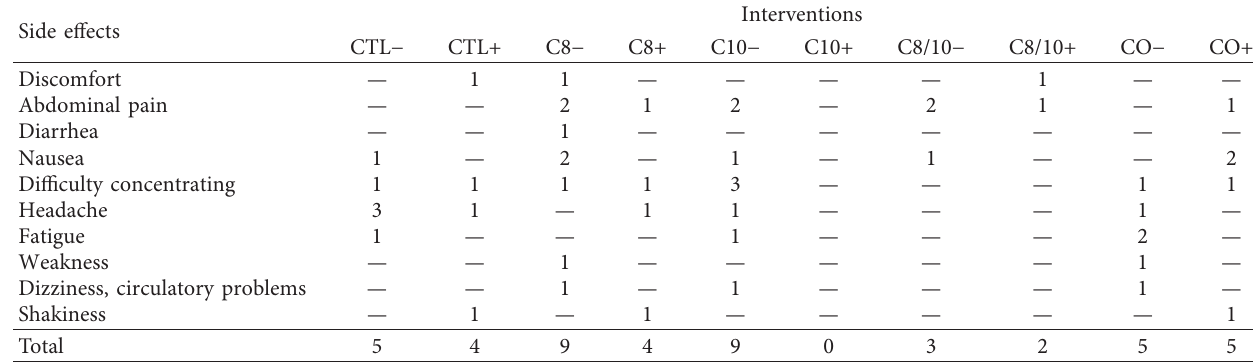
Table 2: The frequency of side effects in all interventions.